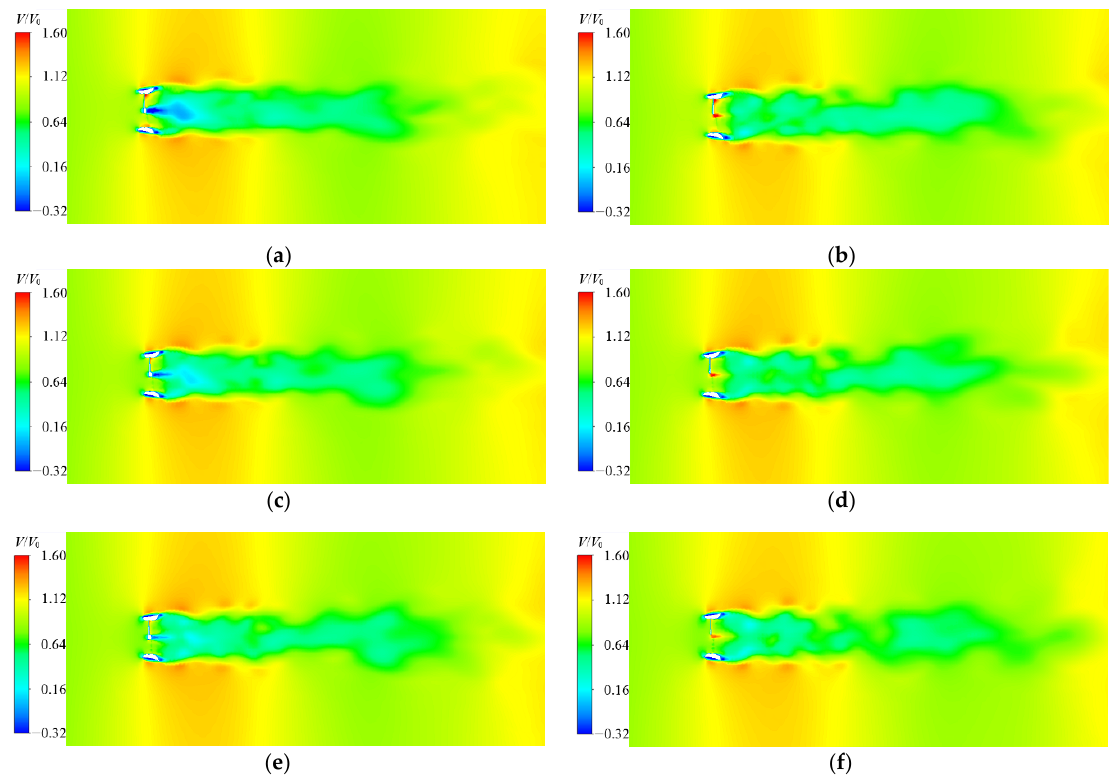
Figure 13. Axial velocity contours for the two configurations in the central x - z plane: ( a ) DT for TSR = 3.0; ( b ) RDT for TSR = 3.0; ( c ) DT for TSR = 4.0; ( d ) RDT for TSR = 4.0; ( e ) DT for TSR = 5.0; ( f ) RDT for TSR = 5.0.